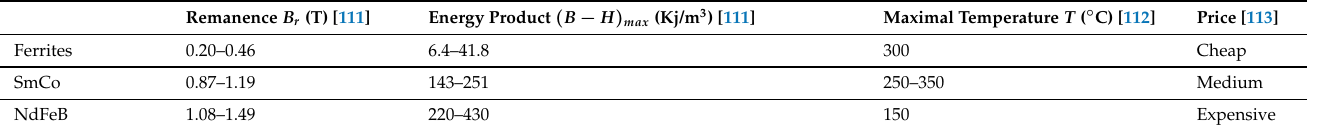
Table 5. The main characteristics of some permanent magnets.